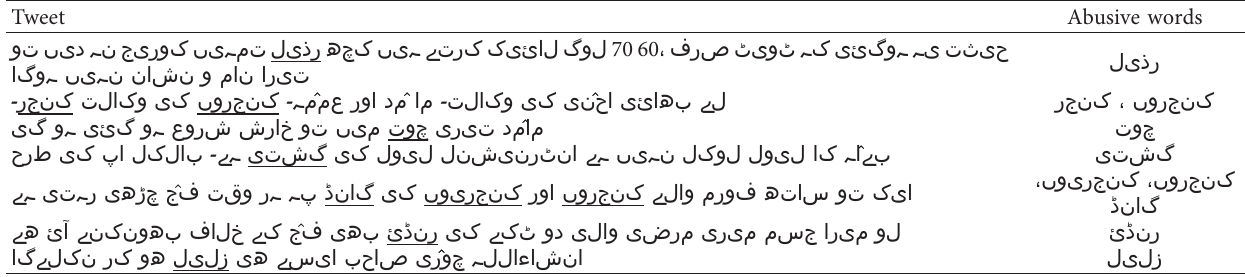
Table 2: Examples of Tweets with abusive words in Perso-Arabic Urdu.